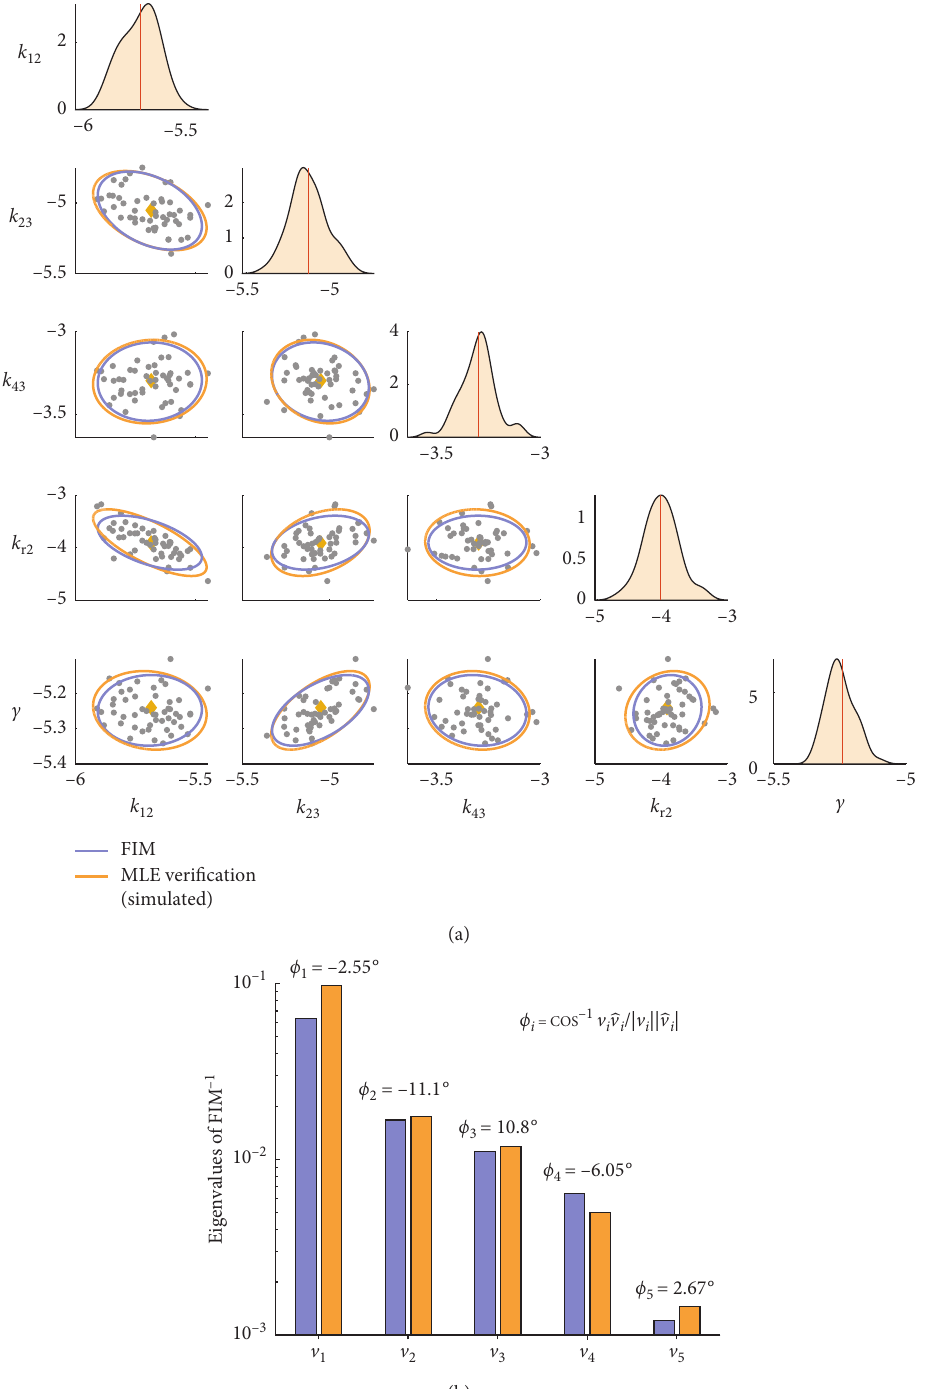
Figure 2: Verification of the FSP-FIM for the time-varying HOG1-MAPK model. (a) Marginal parameter histograms (top panels) and joint scatter plots (gray dots) for the MLE parameter estimates from 50 simulated datasets and for a subset of model parameters. All parameters are shown in logarithmic scale. The ellipses show the 95% CI for the inverse of the FIM (purple) and Gaussian approximation of MLE scatter plot (orange). The yellowdotsindicatethe“true”parametersatwhichtheFIMandsimulateddatasetsweregenerated.(b)Rank-pairedeigenvalues ( v i ) forthecovariance of MLE estimates (orange) and inverse of the FIM (blue). The angles between corresponding rank-paired eigenvectors ( ϕ i ) are shown in